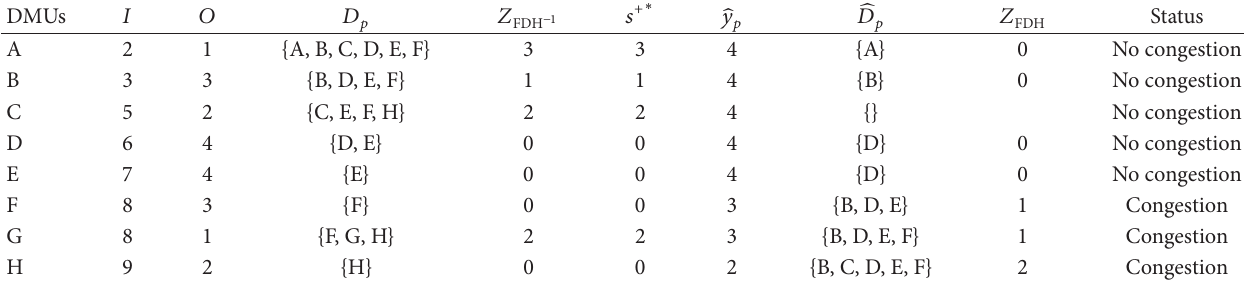
Table 1: Data set and results of Part (a) of the proposed algorithm in Example 1.